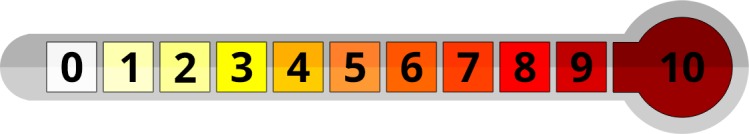
The Orgasmometer-F.Considering a Likert scale ranging from 0 to 10, where 0 corresponds to the absence of orgasmic perception and 10 to maximum perceived orgasmic intensity, how do you evaluate your orgasmic intensity in the last six months?